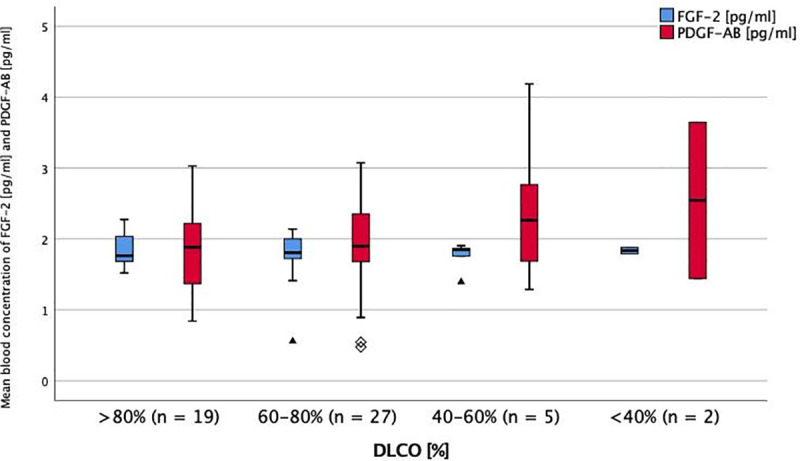
Serum levels of FGF-2 and PDGF-AB in impairment of DLCO at baseline.Mean blood concentration of FGF-2 and PDGF-AB in different stages of DLCO impairment. DLCO = diffusion capacity of carbon monoxide. FGF-2 = fibroblast growth factor-2. PDGF-AB = platelet derived growth factor-AB. * = p < 0.05 (ANOVA + Tukey-test as post-hoc test for multiple comparisons). No significant differences between the groups.